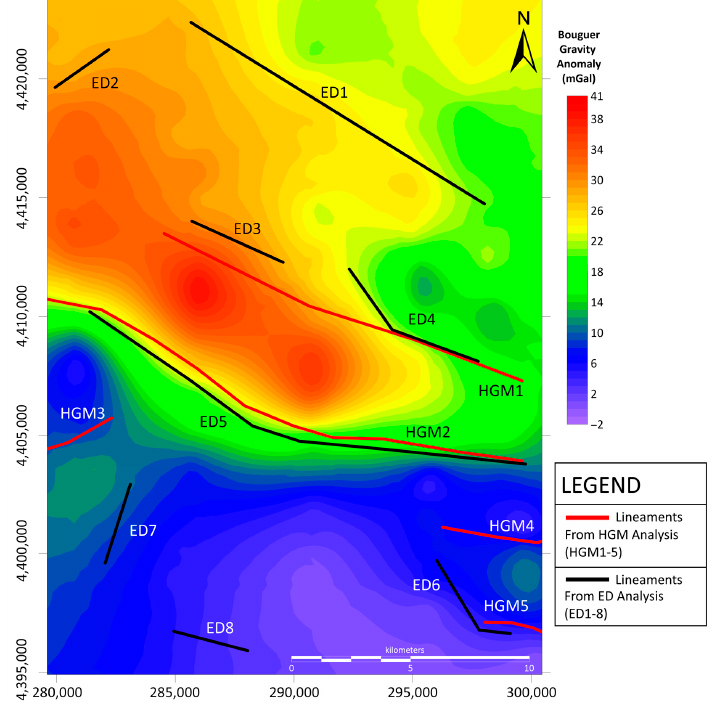
Figure 9. The HGM and ED lineaments together superimposed on Bouguer gravity anomaly map. (Datum: WGS84 UTM Zone 36 N). When the lineament solutions are examined together with the faults that fall within the study area, and are already known in the literature, a great deal of consistency is no- ticeable (Figure 10). While the edge detection solutions with the northern fault group